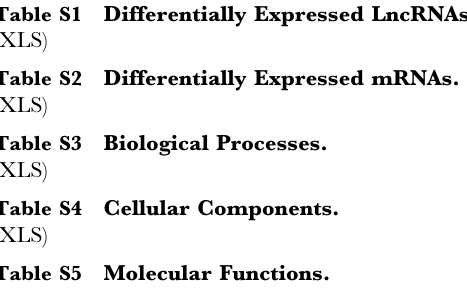
Table S6 Pathway Analysis. Table S7 Differentially Expressed Enhancer LncRNA. Table S8 Enhancer LncRNAs nearby coding gene data. Table S9 HOX cluster profiling. Table S10 Differentially Expressed Rinn LincRNAs. Table S11 LincRNAs and their nearby coding gene data table. Table S12 Primers used for Q-RT-PCR. Table S13 Differentially Expressed both LncRNAs and their related mRNAs. Table S14 Function of the genes correlated the candi-